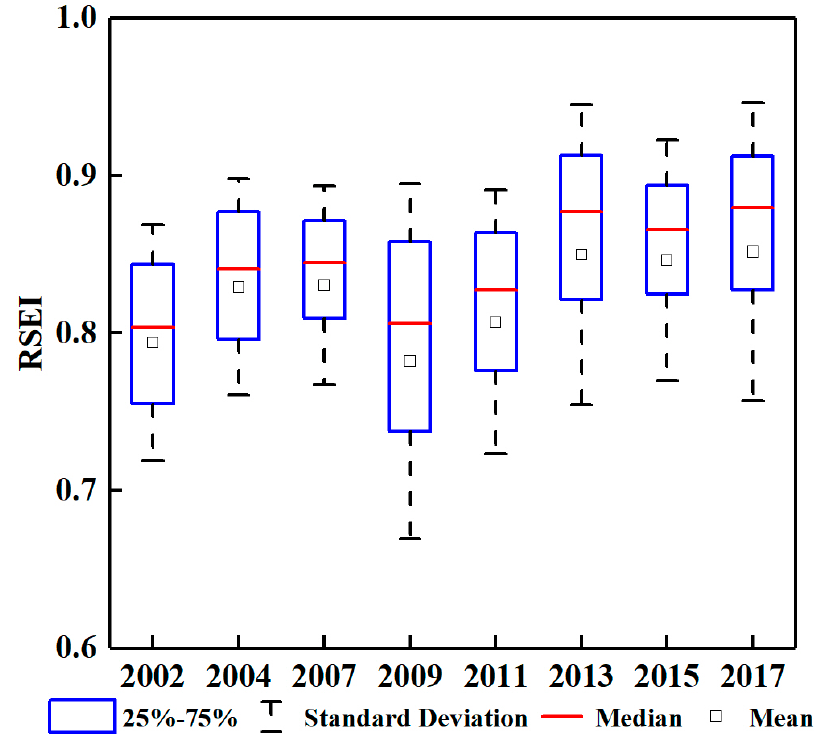
Figure 3. Box plot showing the distribution of RSEI values in the study years.